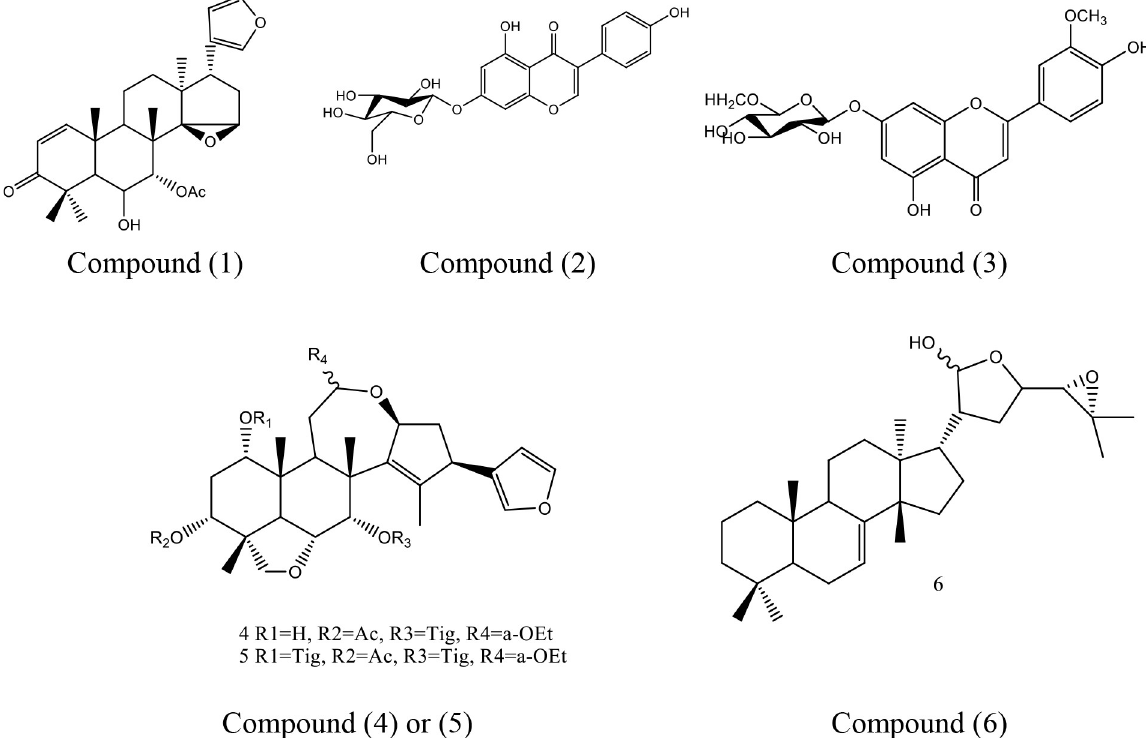
Fig 1. Structure of the isolated compounds from A . indica L. (compounds 1, 2, and 3) and from M . azedarach L. (compounds 4, 5, and 6).